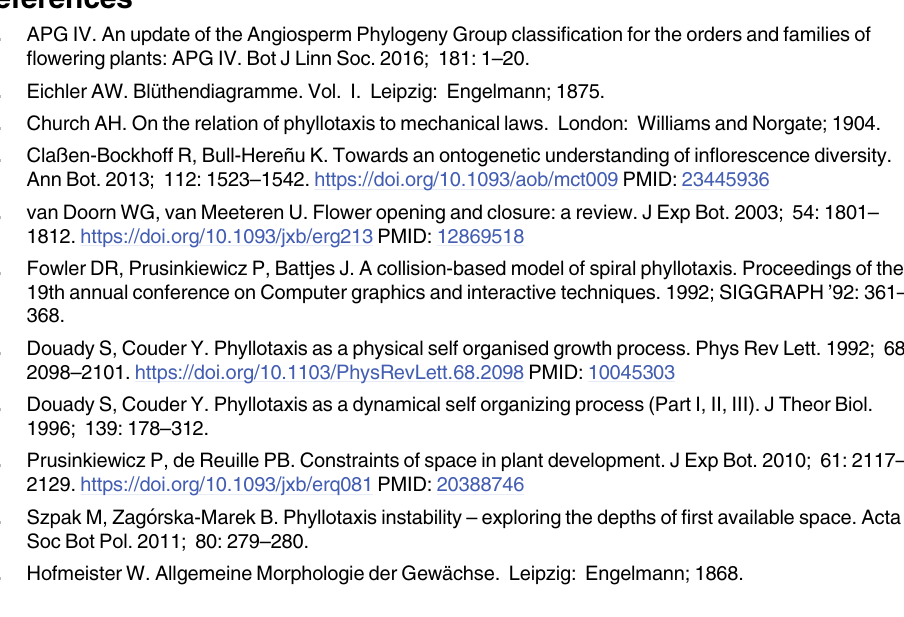
S1 Table. Comparison of head diameter and flower meristem extent in the basal, middle and apical zones of the heads in stage S3 (Mean values and standard deviation from 10 measurements). S2 Table. Head diameter at the basal and middle parts in three developmental stages (S1, S2, S3). Mean values and standard deviation from 10